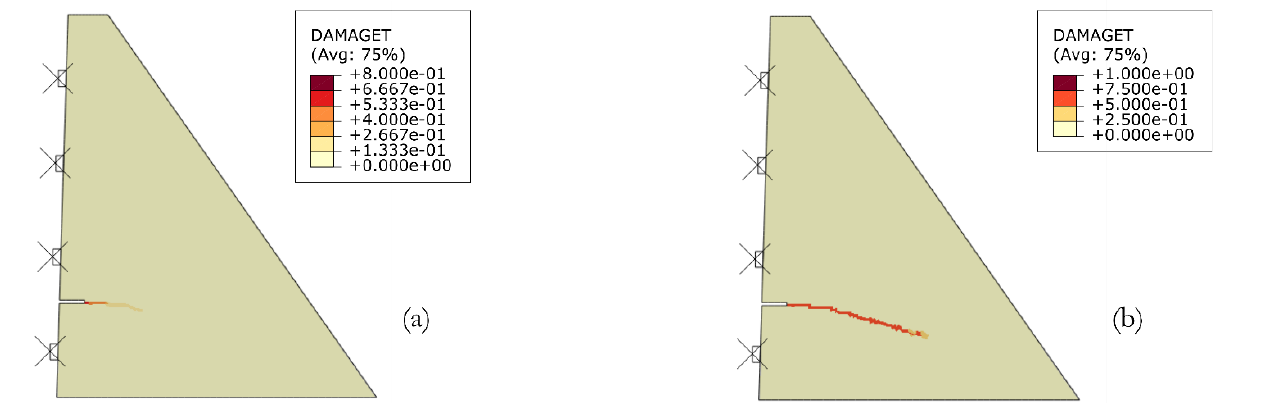
Figure 11. Crack trajectories for mesh 02 considering the following increments: ( a ) 47, ( b ) 190. Algorithm 1. Python script that establishes OS shell communication with Abaqus and terminates the anal- ysis if a prescribed load ratio is achieved.